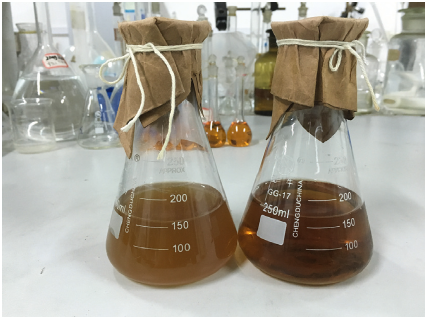
Figure 4: Sporosarcina Pasteurii strains were cultured in liquid medium for 2 days (left side is inoculated conical flask and the right side is blank